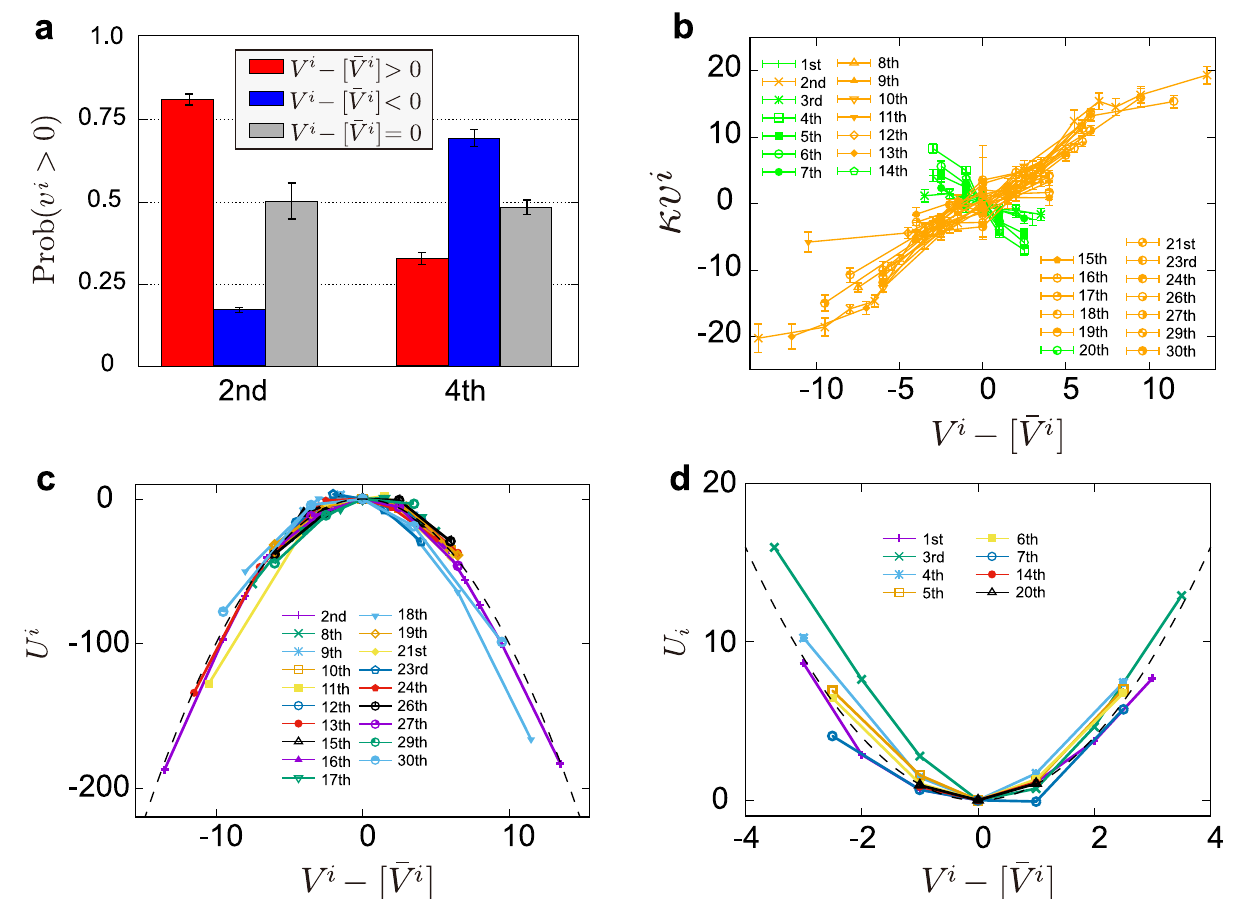
Fig 5. Classification into economically-motivated (EM) strategies and arbitrage-motivated (AM) strategies. (a) Probabilities for the bank to take a long contract in the next time period, conditional on the differences between its current and historical average position (data for the second and fourth top banks). Positive (negative) differences are shown as red (blue) bar plots. When there is no difference, the bar plot is grey. (b) Empirical relationship between the differences in the current and historical average positions and the trading amount v i of the next transaction. We measure the magnitude of the slopes and the range of fitting errors using gnuplot with the Levenberg–Marquardt algorithm [21]. The orange and green lines show the positive or negative slopes, respectively, after taking fitting errors into account. Note that we aggregated samples to ensure the presence of more than 300 samples in each bin. (c,d) Scaling plots of (b). Repulsive (c) and attractive (d) potential functions collapse onto a quadratic master curve. This figure is obtained for κ = 15, which is the number of past transactions over which the averaging over positions is performed (see Eq